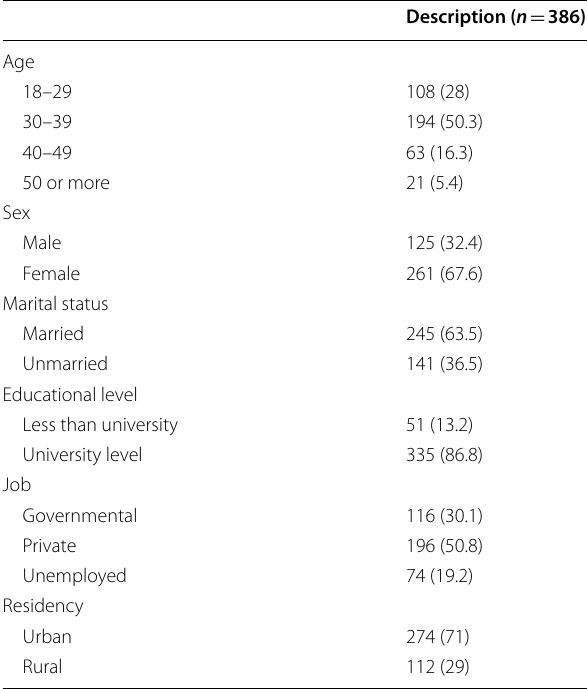
Table 1 Sociodemographic data of the participants